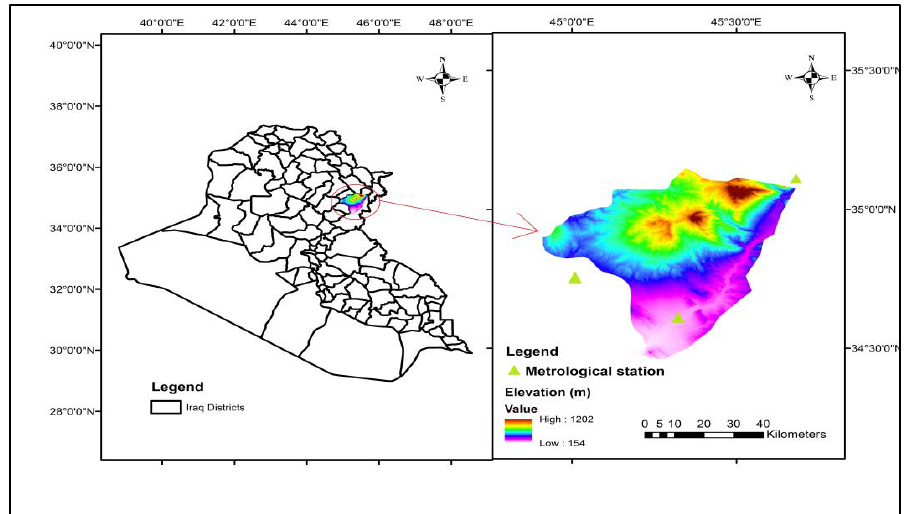
Figure 1. Study area.